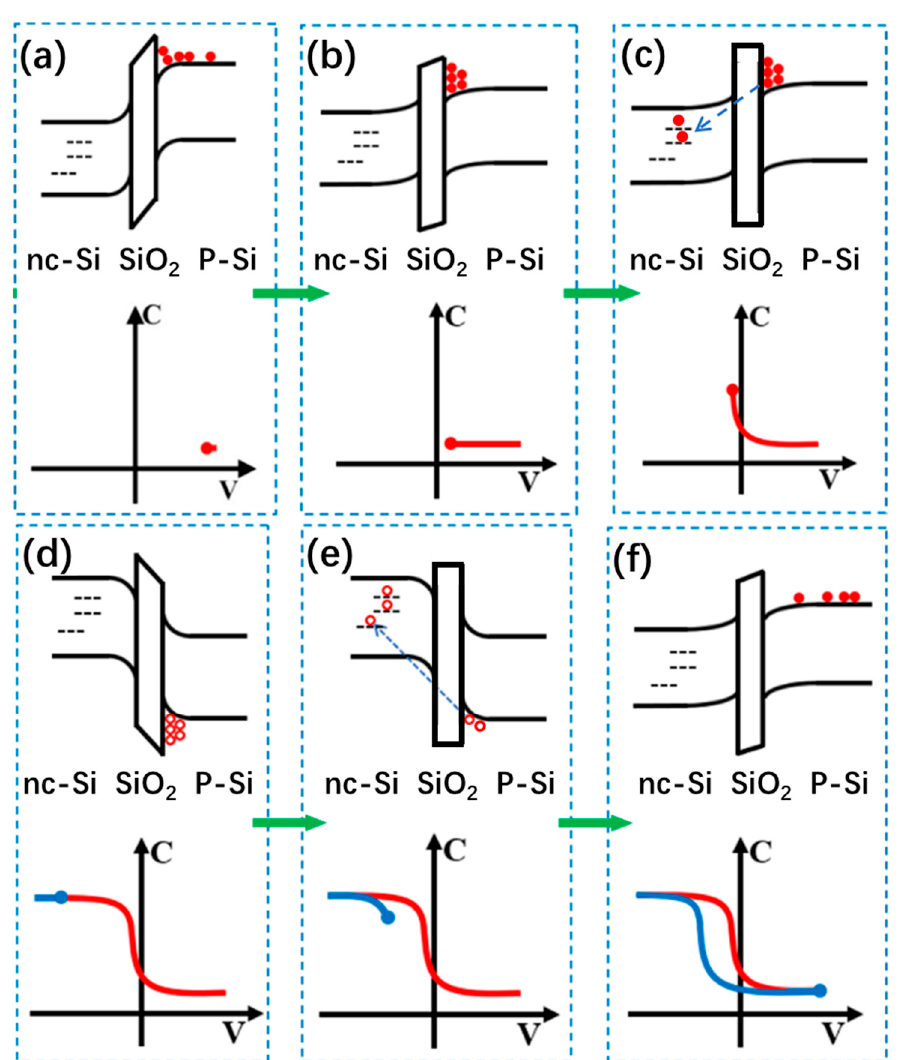
Figure 3. Formation mechanism of the counterclockwise C–V hysteresis of the SiN x /nc-Si(a-Si)/SiO 2 floating-gate MOS structure. ( a – c ) Under the positive gate voltage, the electrons tunnel from the substrate into the nc-Si layer, leading to the positive movement of the flat band voltage as shown by the red lines. ( d – f ) Under the negative gate voltage, the holes tunnel from the substrate into the nc-Si layer, leading to the negative movement of the flat band voltage as shown by the blue lines.And a counterclockwise C–V window is formed. The hollow circles and the solid circles represent the holes and electrons, respectively. The blue arrow represents the direction of electron tunneling and hole tunneling.